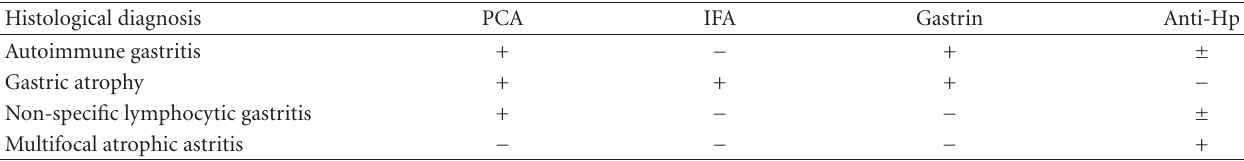
Table 2: Biochemical-antibody results in relation to the histological diagnosis of gastritis in the studied population. Histological diagnosis PCA IFA Gastrin Anti-Hp Autoimmune gastritis + − + ± Gastric atrophy + + + − Non-specific lymphocytic gastritis + − − ± Multifocal atrophic astritis − −